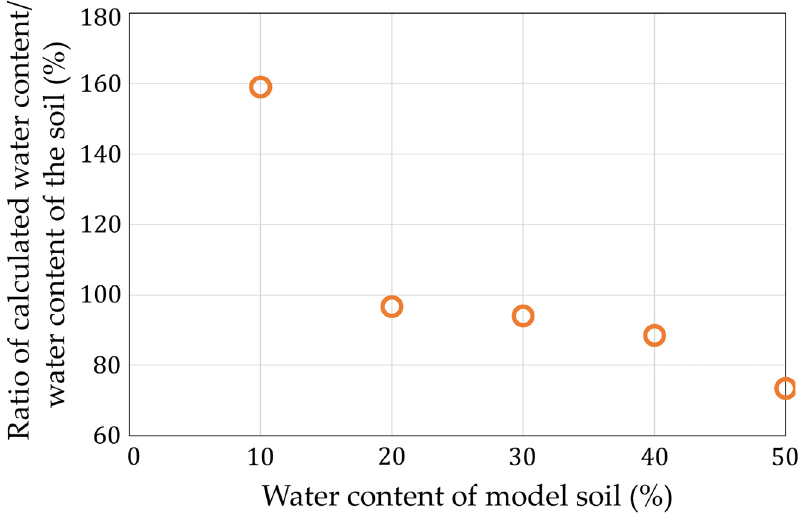
Figure 18. Deviation of the measurements with impedance analyzer in Figure 17.